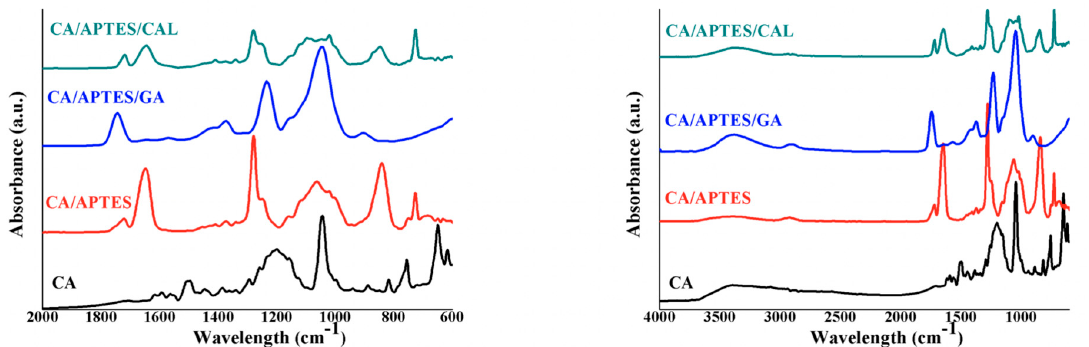
Figure 3. Fourier transform infrared spectroscopy ( FT-IR) spectra of synthesized CA, CA/APTES, CA/APTES/GA, and CA/APTES/CAL membranes with details for the range 600–2000 cm − 1 (left) and 500–4000 cm − 1 (right). GA: Glutaraldehyde.